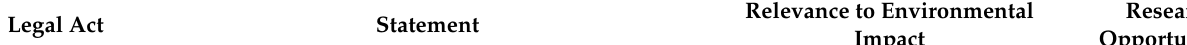
Explore novel waste recovery and value addition strategies for waste types currently designated for a cradle-to-grave